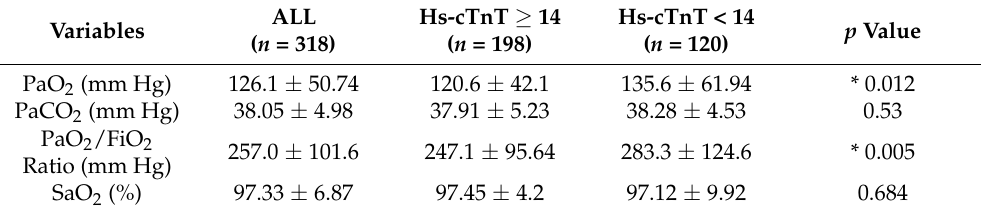
Table 2. Lowest postoperative arterial blood gas parameters relative to hs-cTnT following OPCAB. Variables ALL ( n = 318)